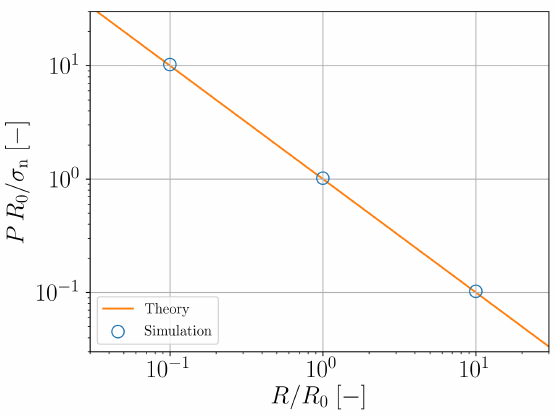
Figure 8. Young–Laplace scaling (Equation (53)) of the normalized droplet pressure as function of the normalized droplet radius.